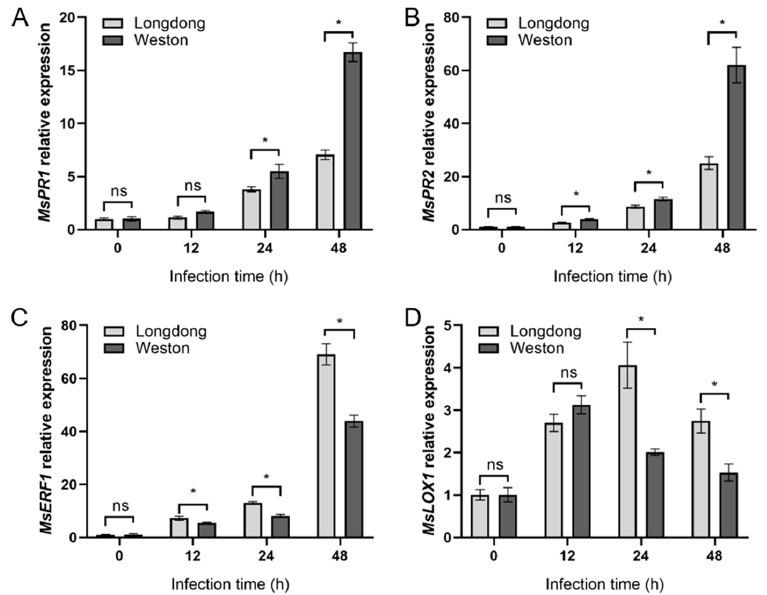
Figure 8. Relative expression of plant hormone-related genes in resistant or susceptible alfalfa vari- eties infected by Phytophthora cactorum at different time points. Expression of ( A ) MsPR1 , ( B ) MsPR2 , ( C ) MsERF1 , ( D ) MsLOX1 were detected at 0, 12, 24, or 48 hpi. Data are the means of six independent experiments and error bars represent SD. Asterisks at the top of the bars indicate statistical signifi- cance (T-test, p < 0.05).